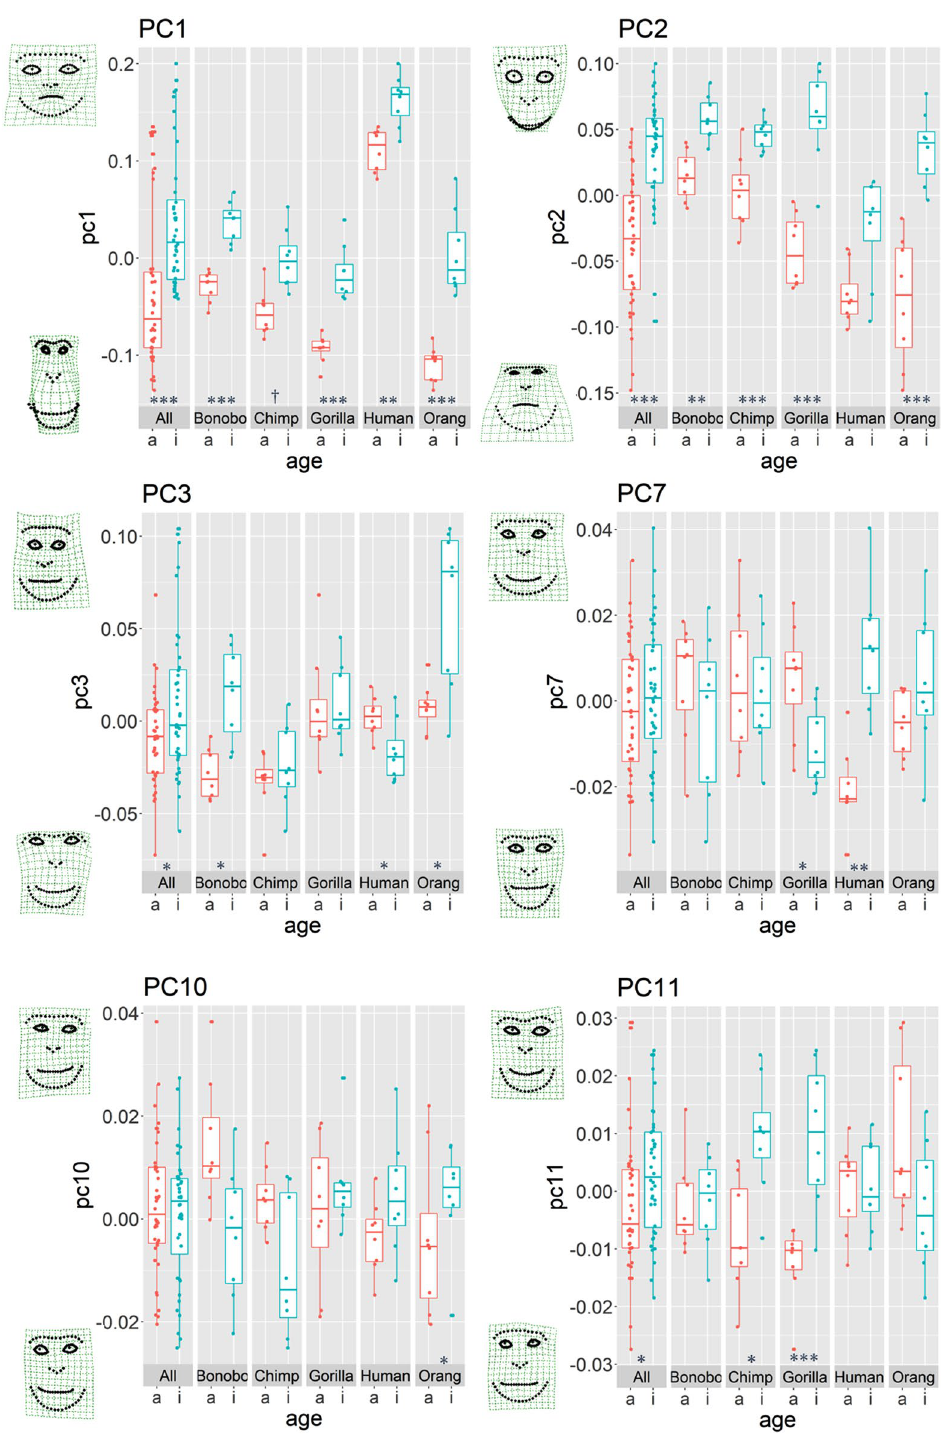
Figure 3. Scores of PCs. Asterisk indicates significant difference of the score between adult and infant faces by permutation tests (*** p < 0.005, ** p < 0.01, * p < 0.05, † < 0.10). Pink plots indicate adult images while blue plots indicate infant images. Faces represent landmark configurations of high (+ 1.5 SD) and low (− 1.5 SD) PC